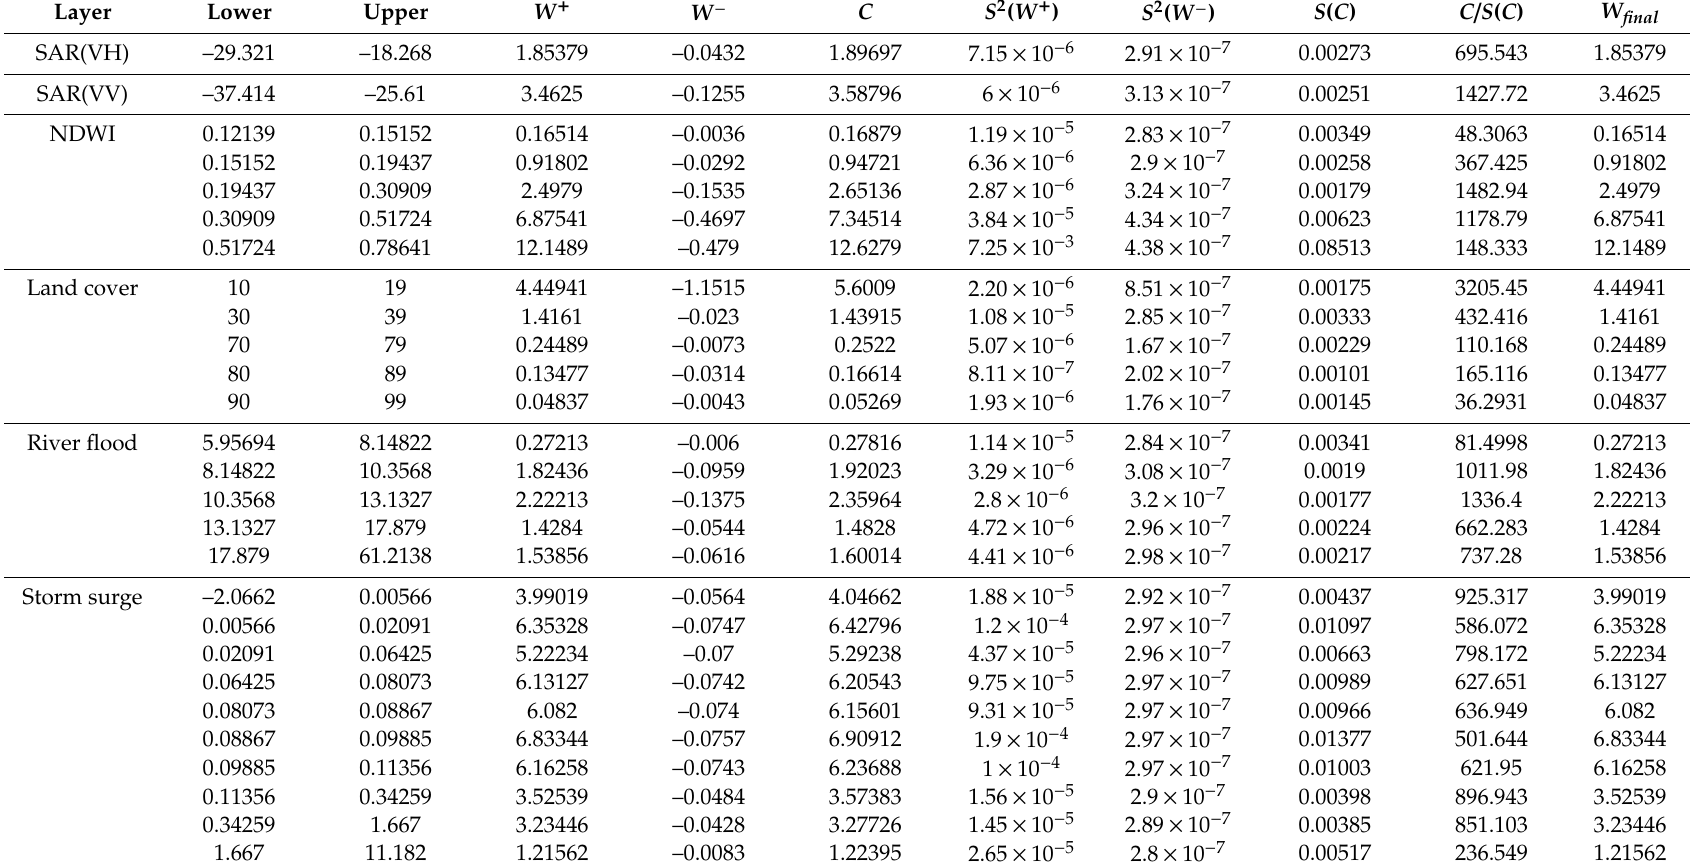
Table 2. Calculation of initial weights ( W + , W − ) , contrast ( C ) , variances of weights and contrast (cid:16) (cid:17) W final weight selected for di ff erent evidence layers. Each row is a spatial layer extracted from one spatial evidence that its value falls between the lower and upper